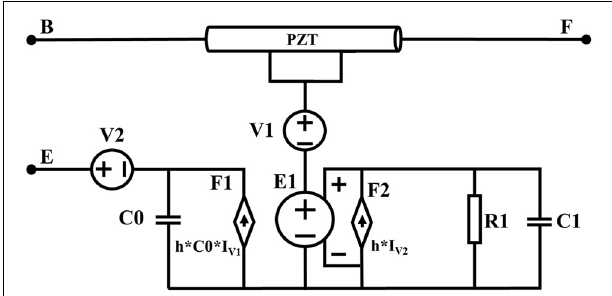
FIGURE 1 | The Leach model of